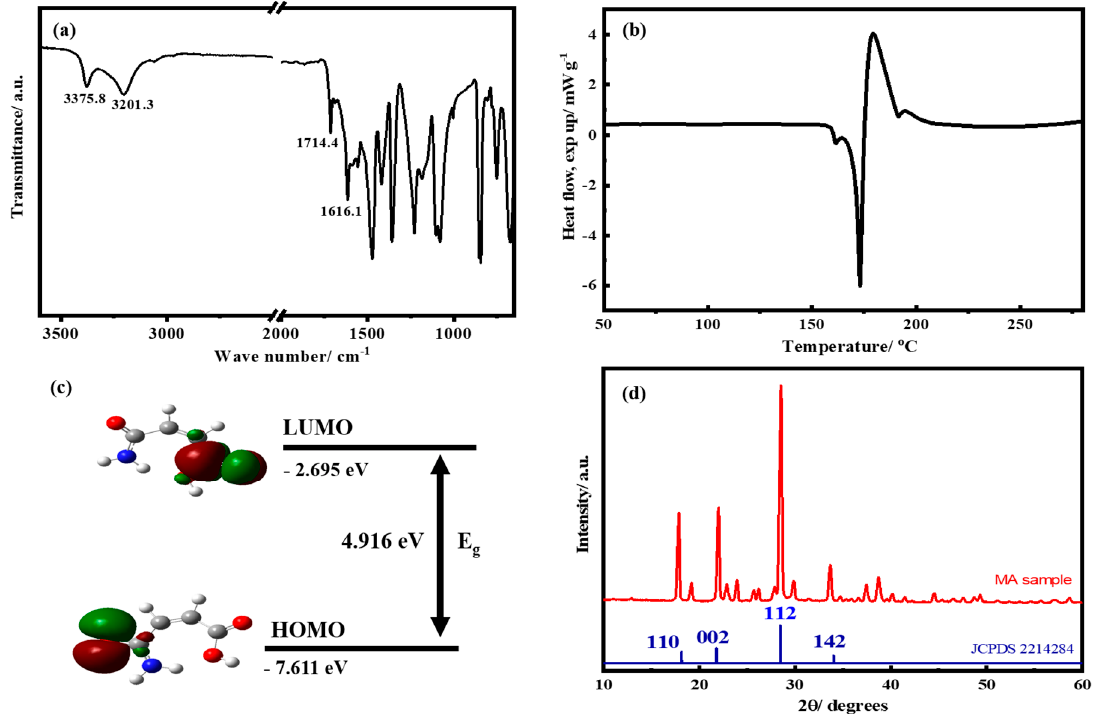
Figure 1. ( a ) The attenuated total reflection (ATR)-FTIR spectra, ( b ) the differential scanning calorimetry (DSC) analysis, ( c ) the calculation of HOMO/LUMO energy level, and ( d ) the XRD pattern of the maleamic acid (MA) material.